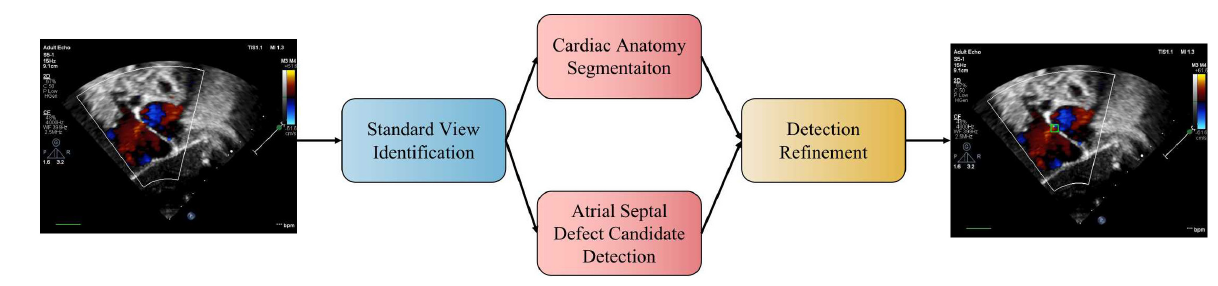
stage is the detection refinement module, which combines the results of the second stage to obtain refined detection